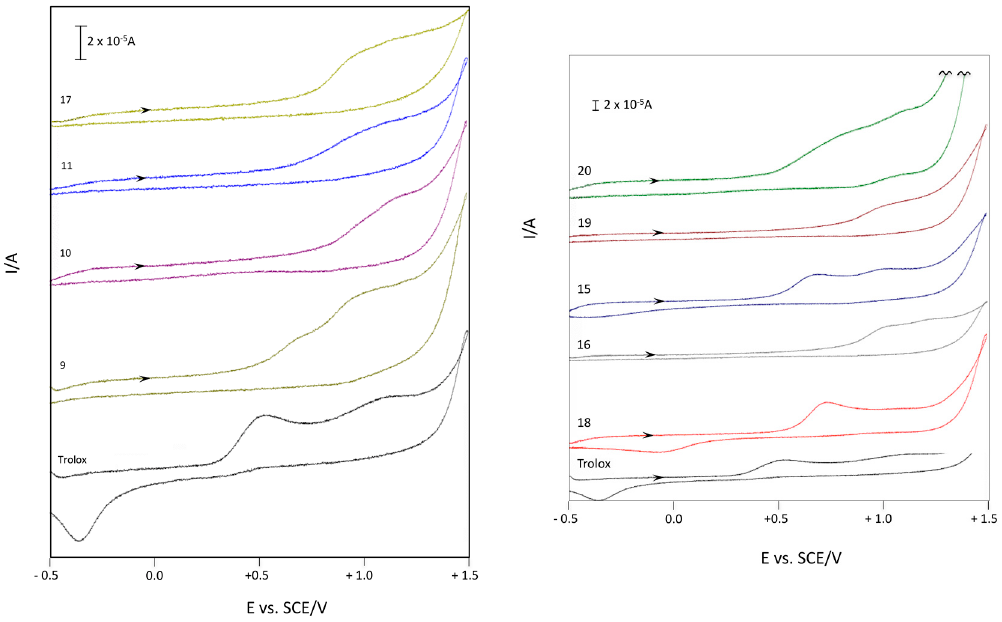
Figure 4. Voltammetric curves of compounds 9 – 11 and 15 – 20 (c = 2 × 10 − 3 M) in aqueous medium (H 2 O-0.5 M NaCl). Starting potential: − 0.5 V; reversal potential: +1.5 V (GC working electrode, ν = 0.2 V·s − 1 , SCE reference electrode, 25 °C, N 2 ).